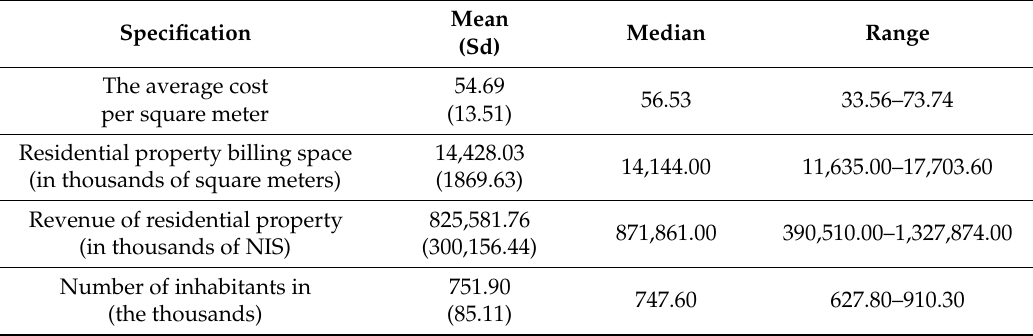
Table 2. Descriptive statistics of the variables for the city of Jerusalem.